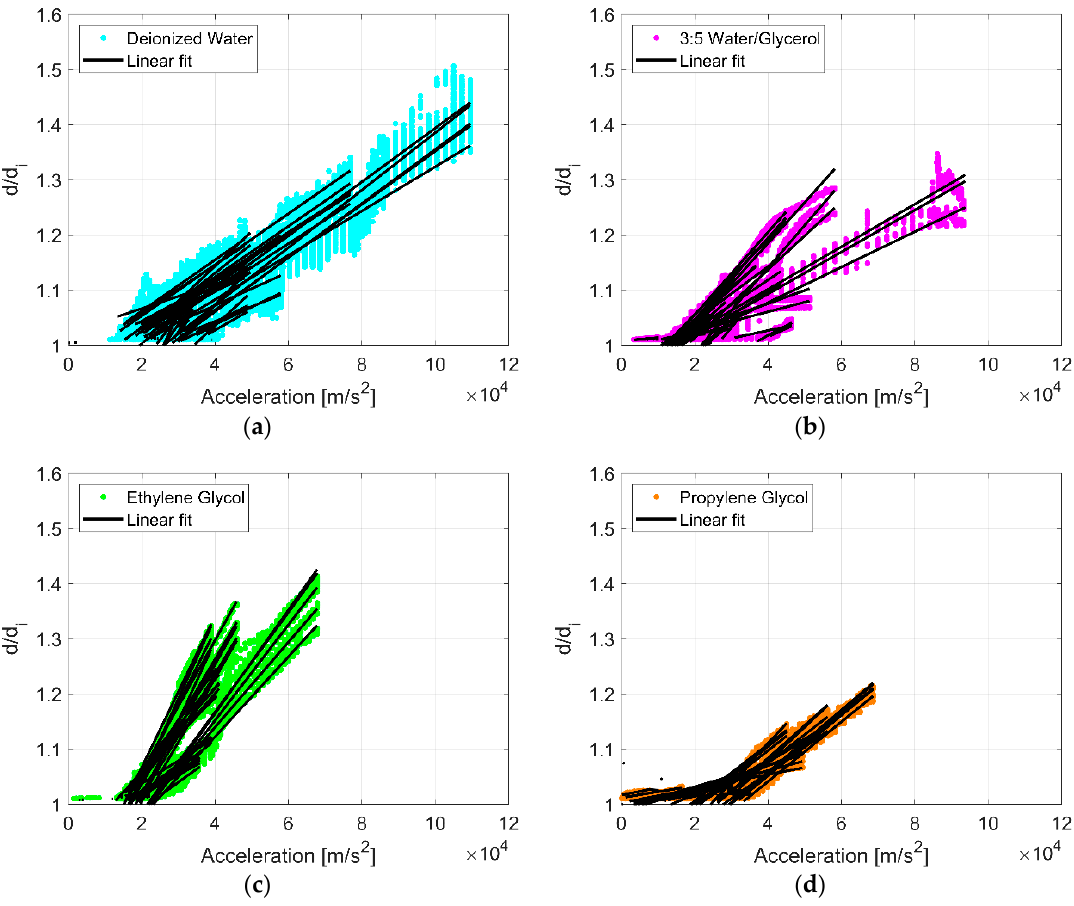
Figure 3. The ratio of droplet diameter to initial droplet diameter (d / d i ) plotted against surface acceleration ( a m ) for all combinations of liquid, droplet volume, and vibration frequency: ( a ) deionized water, ( b ) water / glycerol, ( c ) ethylene glycol, and ( d ) propylene glycol. A linear least squares regression for each droplet volume and vibration frequency for each liquid are plotted in black. Droplet spreading is indicated when d / d i exceeds unity, but was only considered if d / d i exceeded 1.075.